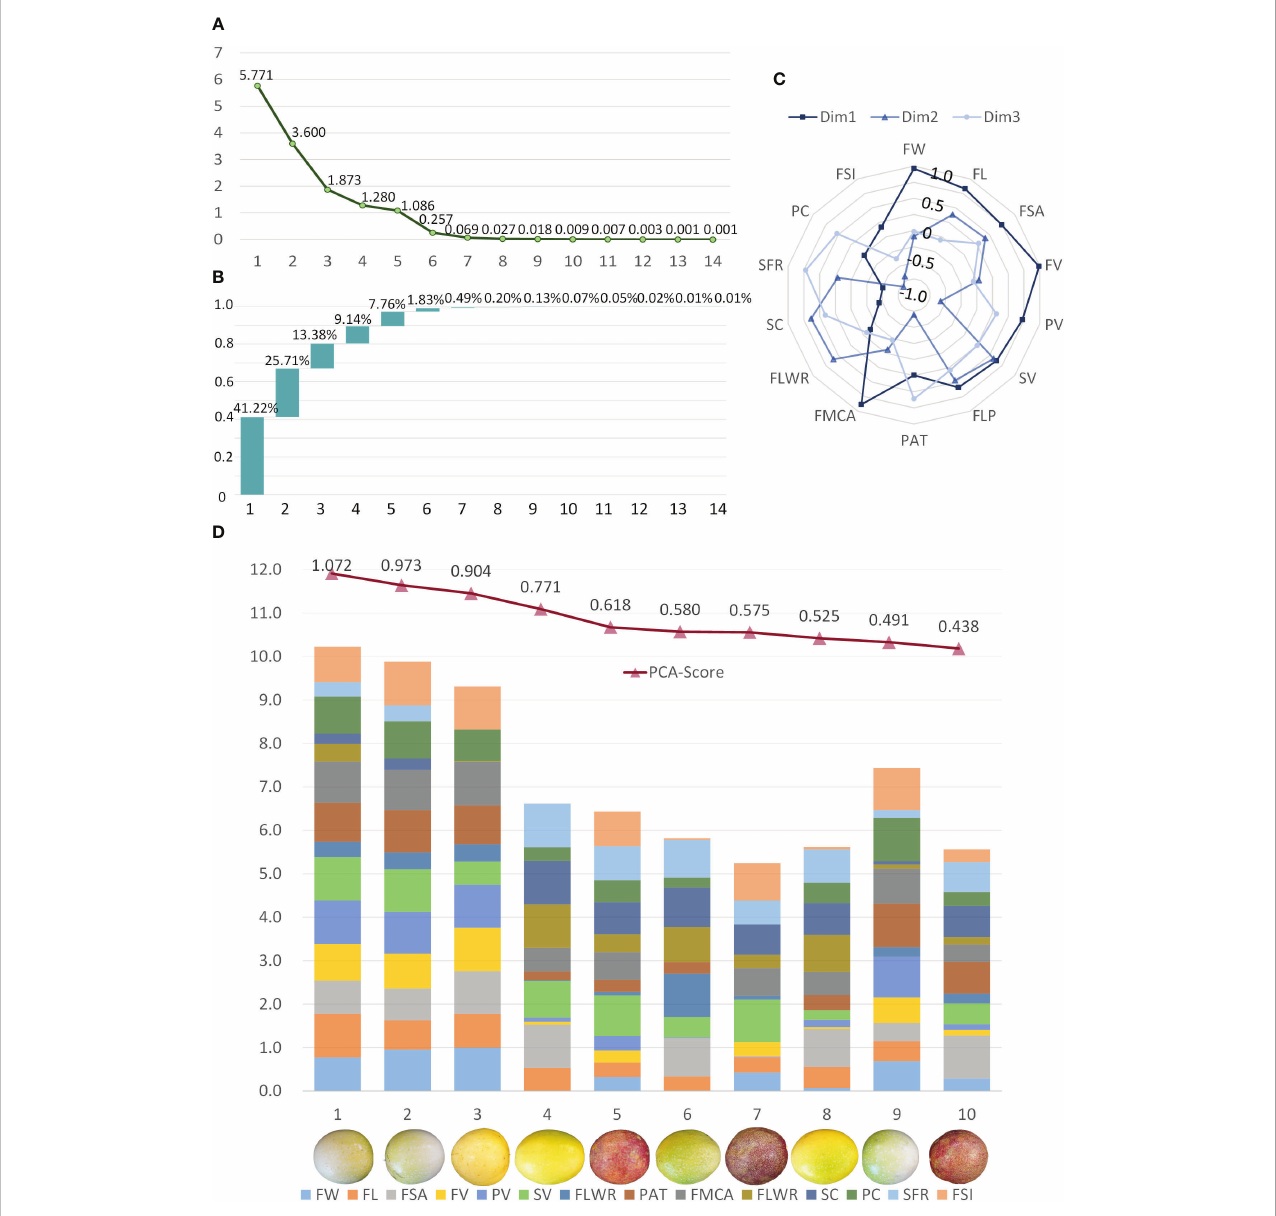
FIGURE 11 Principal Component Analysis using the passion fruit samples and the 14 traits quanti fi ed. (A) The characteristic root of the 14 components in PCA. (B) Scree plot of the percentage of components explained by all dimensions. (C) The contribution of each component to the fi rst three dimensions. (D) Top ten samples of comprehensive quality evaluation and normalized expression of their 14